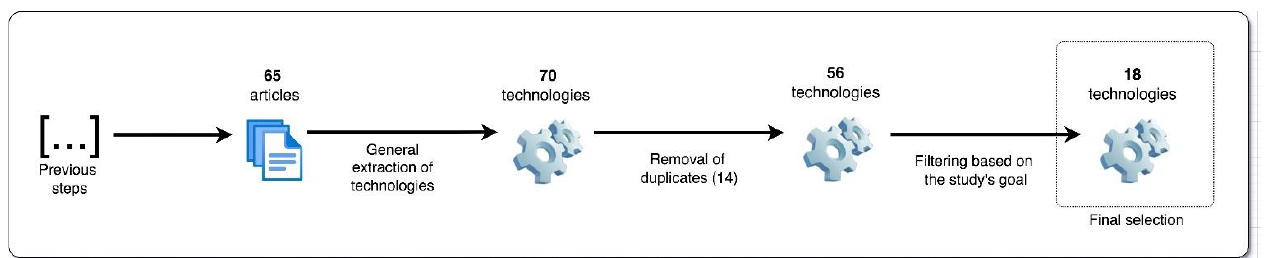
Figure 2. Categorization of papers by year. Source: The authors.